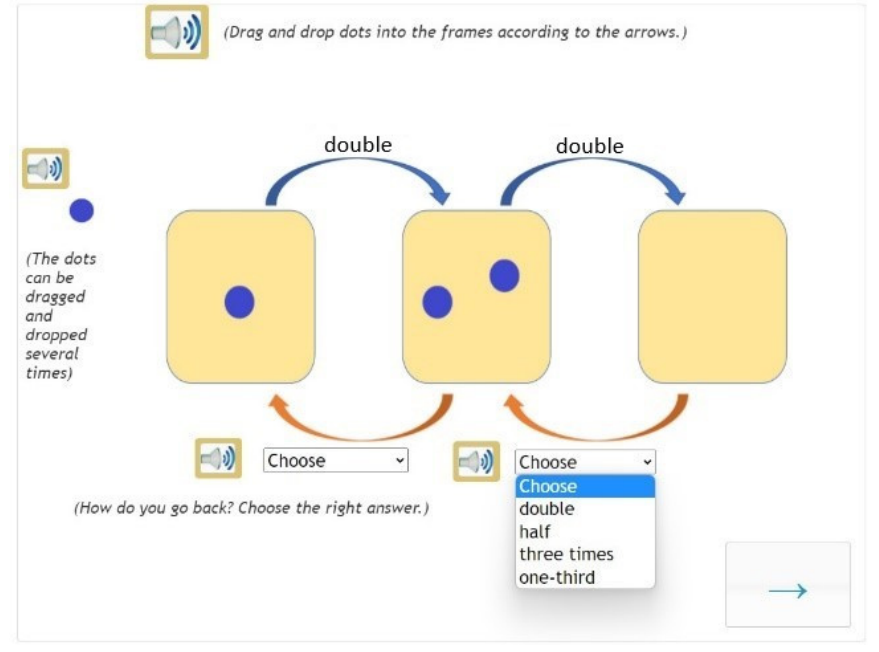
Figure 3. Example of a multiplication task.